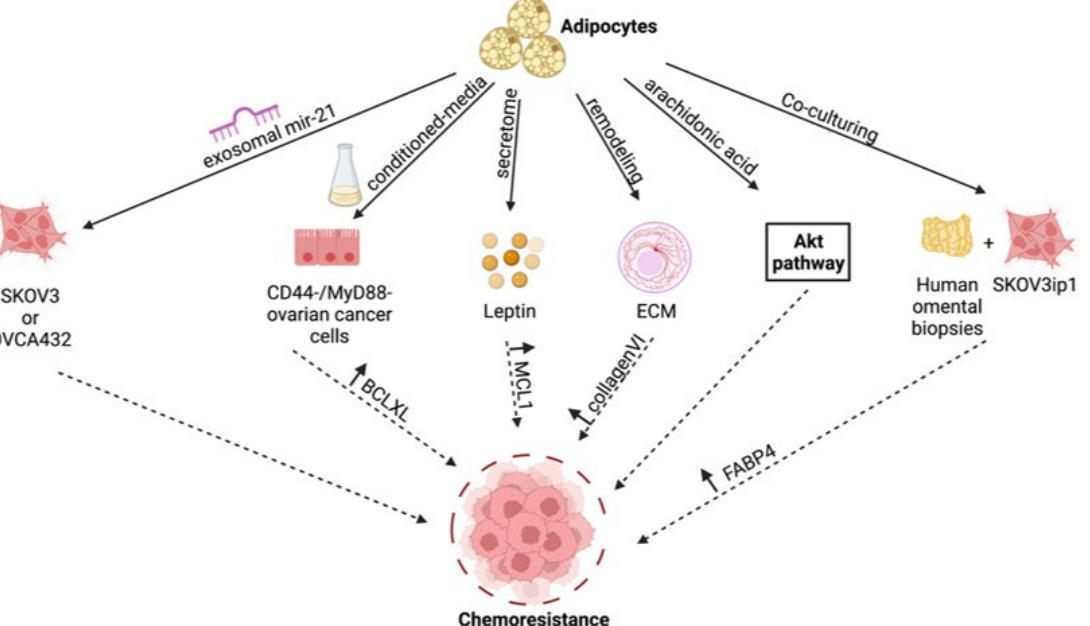
Figure 1. Adipose-induced mechanisms supporting chemoresistance. Figure summarizes the vari- ous molecular mechanisms unraveled in the studies described in text [46,49–51,54–59]. Created with Biorender.com (accessed on 1 April 2022).